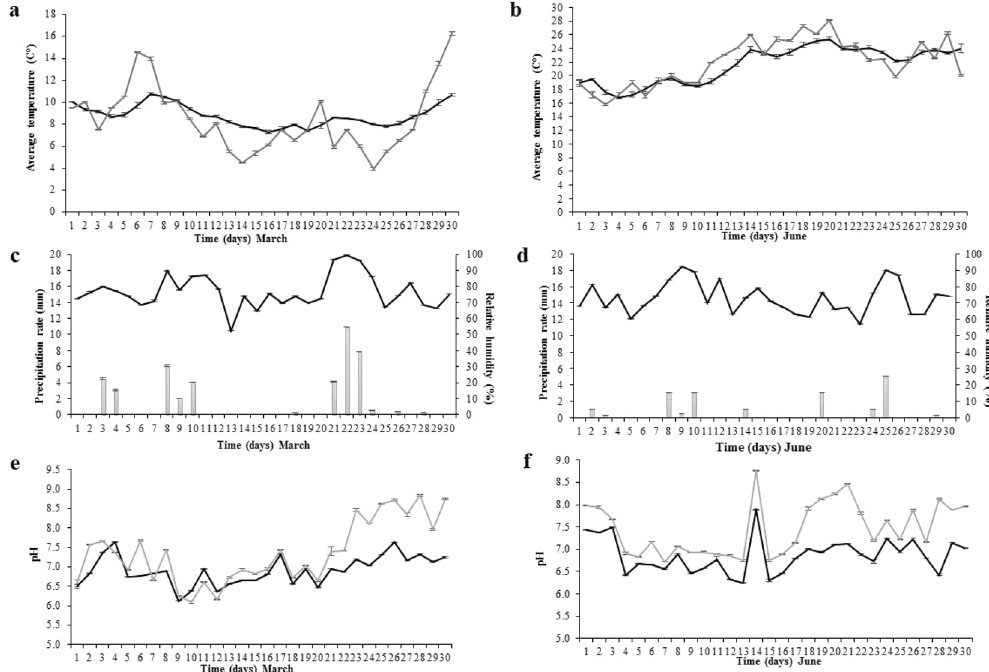
Figure 1. Environmental conditions during the experiment. Average temperature variation: ( a ) March; ( b ) June (soil - gray line; air - black line). Relative humidity and precipitation rate variation: ( c ) March; ( d ) June (relative humidity - black line; precipitation rate - gray bars); Soil pH variation during the investigated period: ( e ) March; ( f ) June (surrounding control soil pH – black line; grave soil pH – grey line). Standard deviations indicated by error bars ( n = 3).